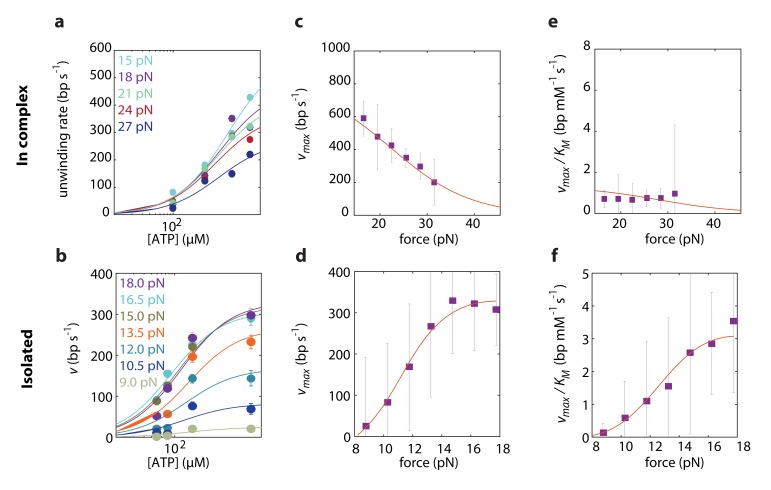
Force dependent Michaelis-Menten curves for RecD in complex(a) and isolated (b). Data shown as mean ± s.e.m. Lines through the data are the result of a global fit to a kinetic model of a Brownian ratchet before ATP binding (Equations S7 and S8 in Supplementary file 2 and Equations S19 and S20 in Supplementary file 3). Different colors indicate different forces. (c–d). Force-dependent vmax for RecD in complex (c) and isolated RecD (d). Discrete data points indicate vmax as a result of fitting Michaelis-Menten curves to the data in a and b for each force separately (shown as fit result ± s.e.). Lines through the data indicate the results of the global fitting. (e–f) Force dependent vmax/KM for RecD in complex (e) and isolated (f). Discrete data points indicate vmax/KM as a result of fitting Michaelis-Menten curves to the data in a and b for each force separately (shown as fit result ± s.e.). Lines through the data indicate the results of the global fitting.